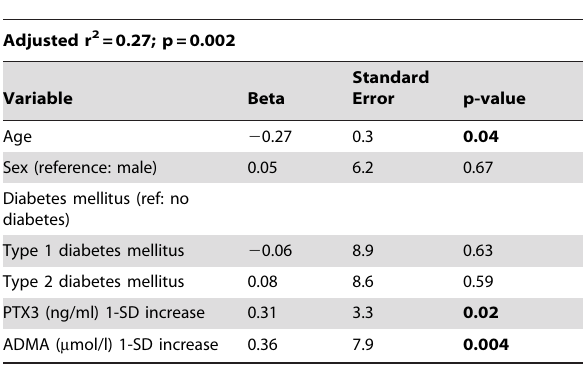
Table 3. Multiple regression model predicting adipose tissue PTX3 mRNA in 56 patients with CKD stage